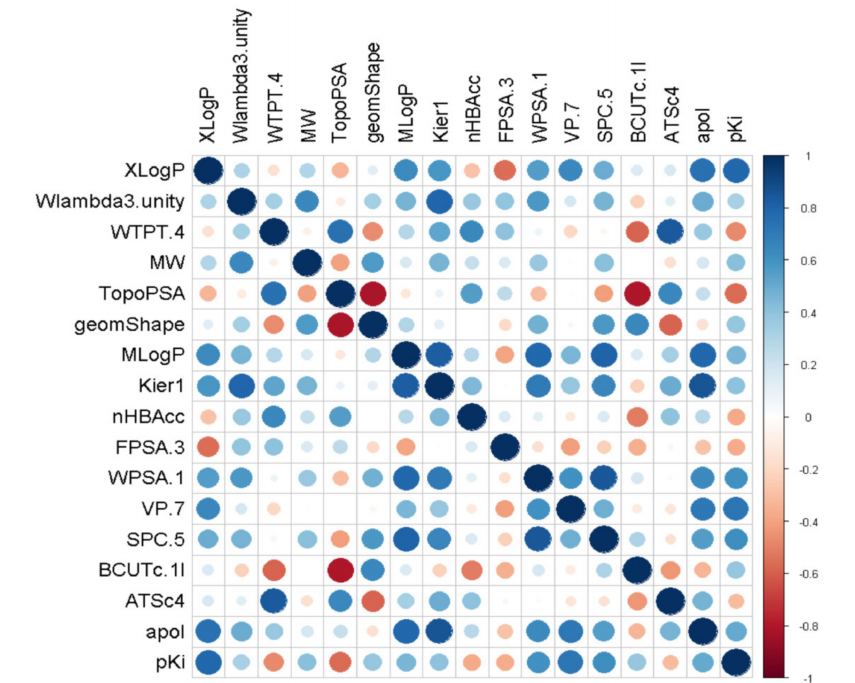
Figure 4. A correlation plot demonstrating the correlation between the dependent variable pK i and descriptor values using di ff erent dot sizes and colors. The larger the dot, the stronger the correlation. Blue indicates a positive correlation, and red indicates a negative